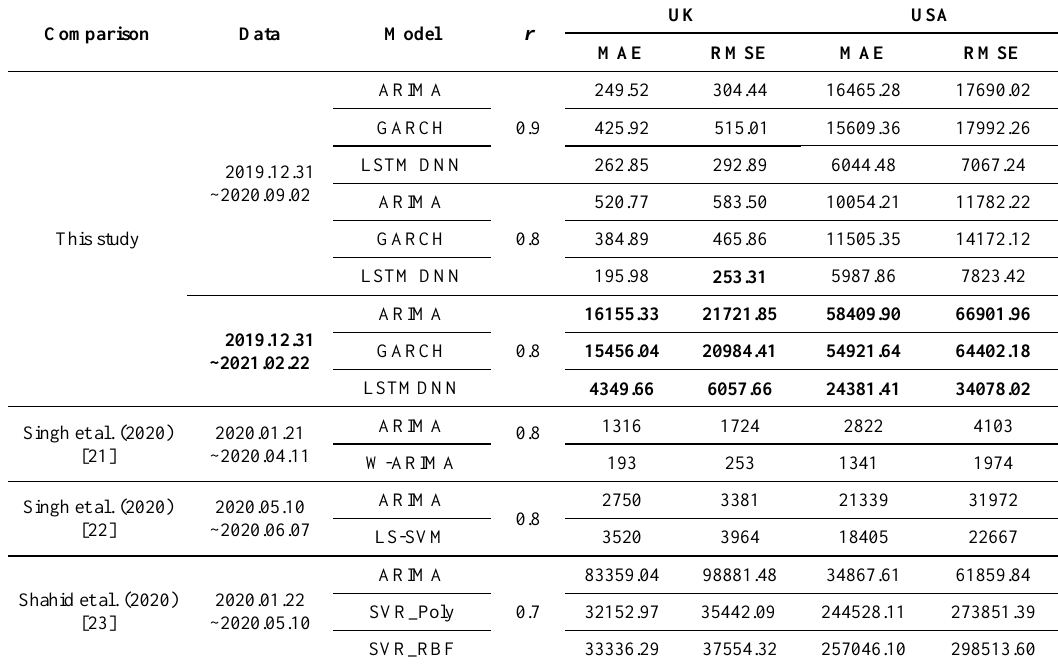
Table 5. Comparison with existing